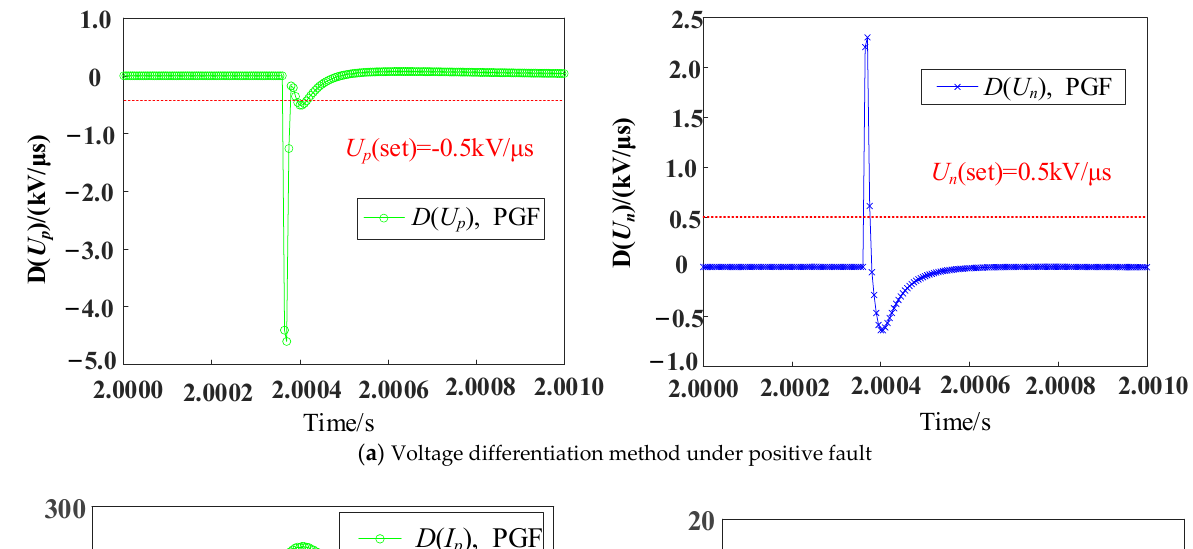
( b ) Figure 14. Wavelet transform results of maximum waveform in the bipolar metal short ‐ circuit fault signal. ( a ) Polar ‐ mode reverse ‐ voltage traveling wavelet mode maximum waveform; ( b ) \zero ‐ mode reverse ‐ voltage traveling wavelet mode extreme waveform. In order to prove the superiority of the fault detection method based on single ended mode inverse traveling waves proposed in this paper, it is compared with voltage differ ‐ entiation and current differentiation methods [32]. In this paper, it is established that a positive, negative, and neutral metallic fault occurs at the midpoint of the line. The differ ‐ ential variation characteristics of voltage and current on the line are shown in Figure 15. The Voltage differentiation or current differentiation method can be used to realize the